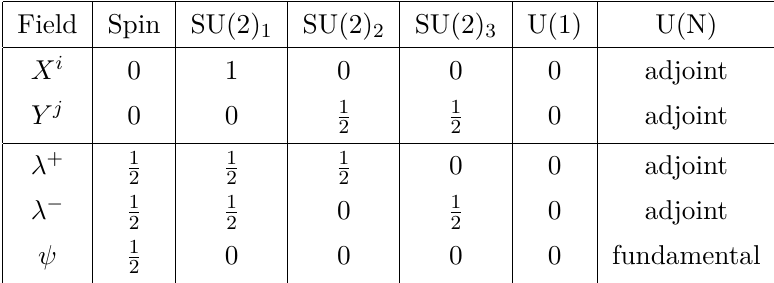
Table 1. Representations of the fields in the dual